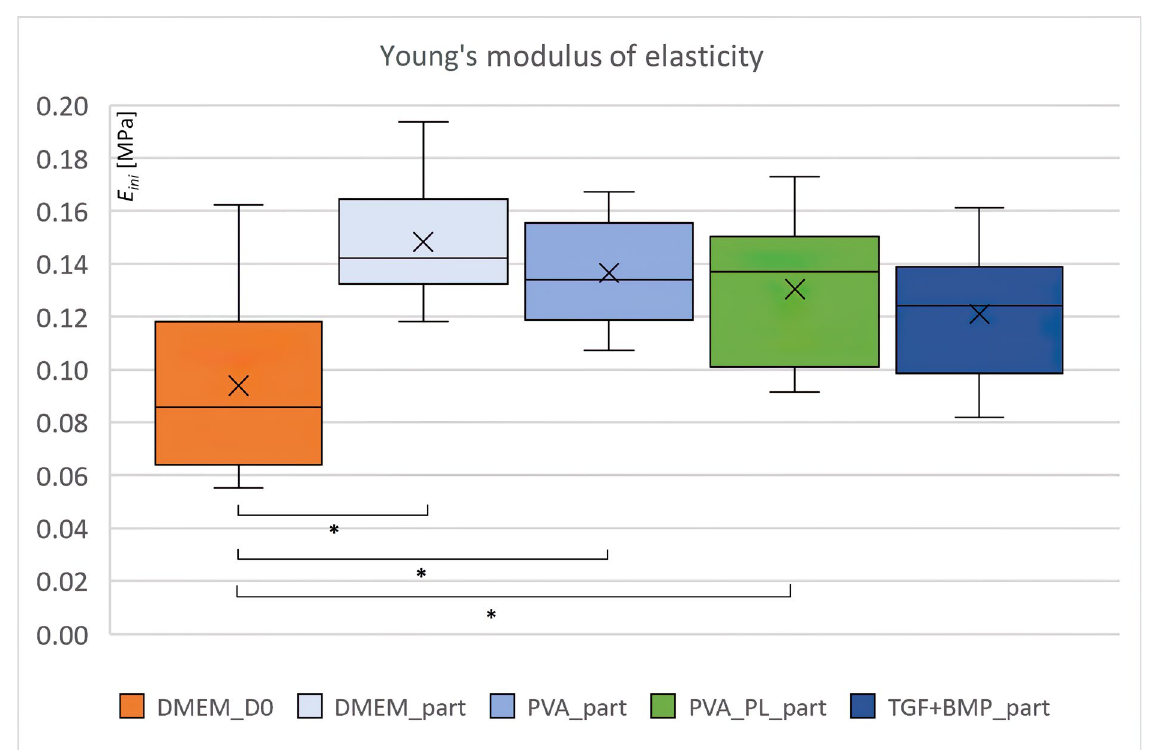
Figure 11. Initial Young modulus of elasticity of reinforced collagen gel with ASCs immediately after preparation, i.e., DMEM_D0, and on day 5 after seeding, i.e., DMEM_part, PVA_part, PVA_PL_part and TGF + BMP_part. box plot diagram, * denotes statistically significant differences (Student’s t -test, 0.05).